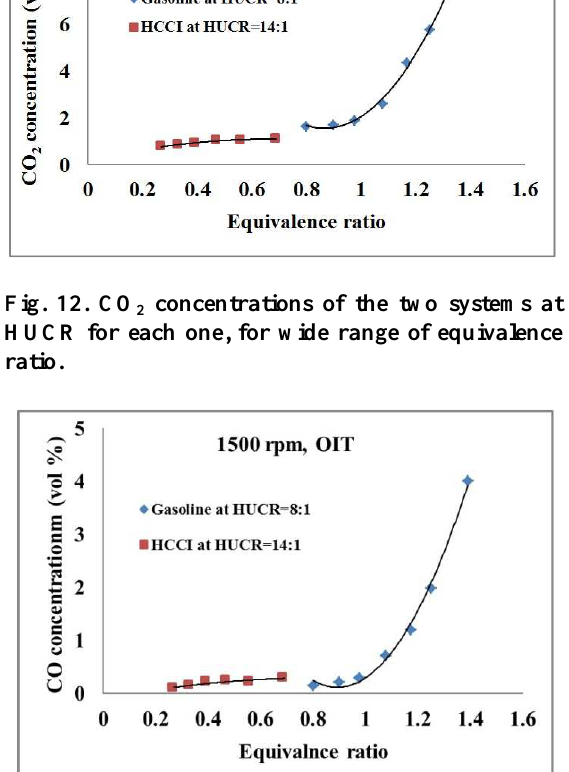
Fig. 15. noise level of the two systems at HUCR for each one, for wide range of equivalence